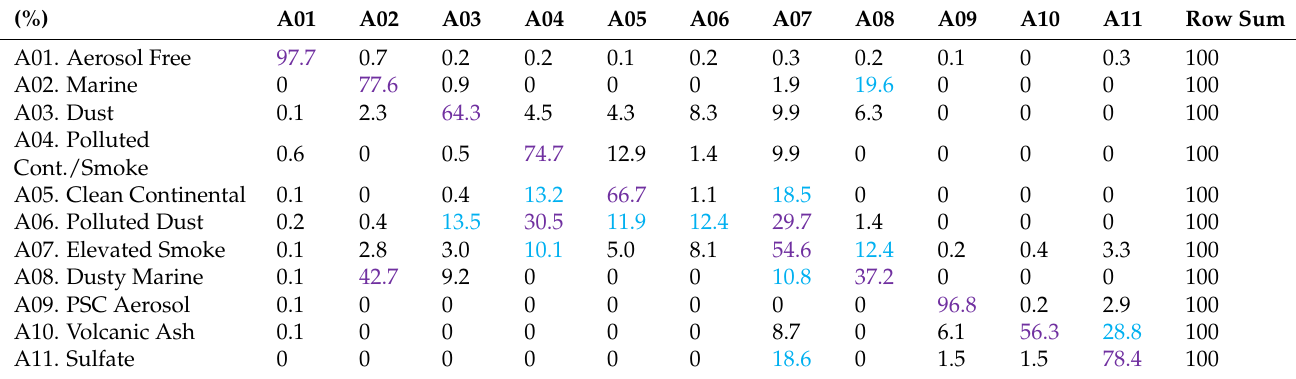
Table 1. Confusion matrix (for July, August, and September 2010 plus stratospheric volcanic eruption and smoke cases) showing the mapping of aerosol subtypes from the CNN (columns) to the COSCAs (rows). The most frequently identified types in classes in each row are highlighted in purple, and the second most frequently identified types in classes are highlighted in